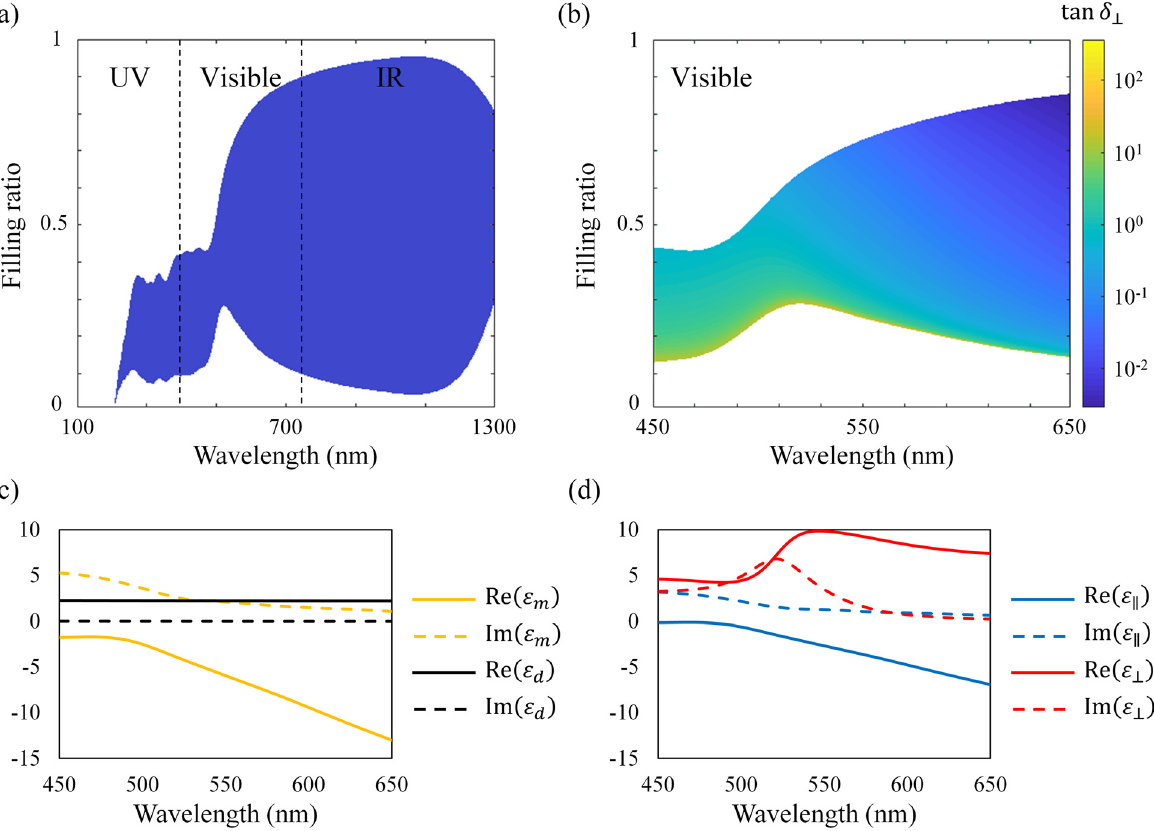
Figure 2: Properties of a vHMM composed of gold and EL8. (a)WorkingfrequencyrangeofavHMMcomposedofgoldandEL8forthenegativerefraction.ThehHMMcomposedofthesamematerialscannot providenegativerefraction.(b)tan δ ⊥ ofthevHMMinthevisiblerange.ThevHMMthathasa fi llingratio f =0.4hasahightan δ ⊥ near λ =500nm. (c) Relative permittivities of gold (yellow lines) and EL8 (black lines). (d) Effective permittivity of the vHMM with the fi lling ratio f =